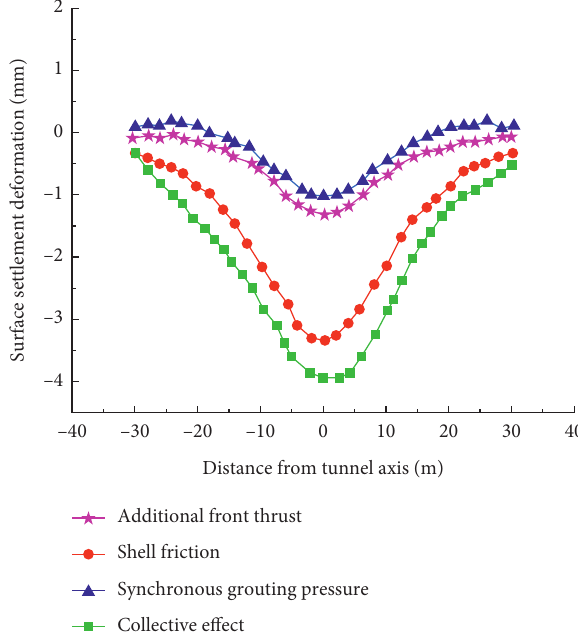
Figure 14: Lateral surface deformation of the ground surface caused by quasirectangle shield